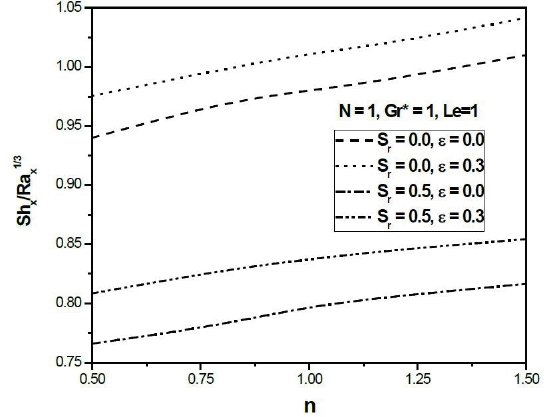
Fig. 5: Variation of mass transfer coefficient against n (Aiding Buoy- ancy.